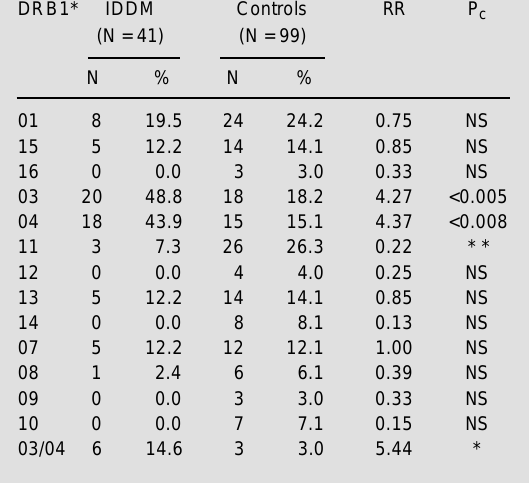
1 - Distribution of HLA-DRB1 phenotype frequencies in IDDM patients and normal individuals (controls). The frequencies are represented as a percentage of pa- tients with each allele. P values were obtained by the chi- square test and corrected for the number of different DRB1 alleles tested (P c , multiplication of P by 13). RR,